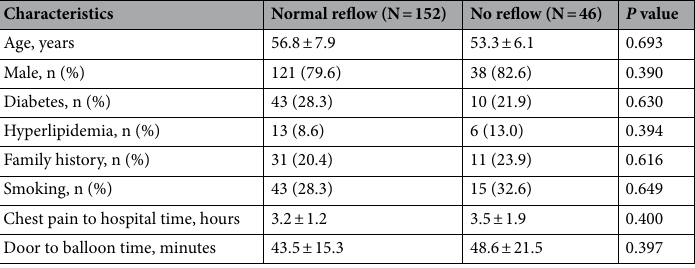
Table 1. Basic clinical features of STEMI patients.